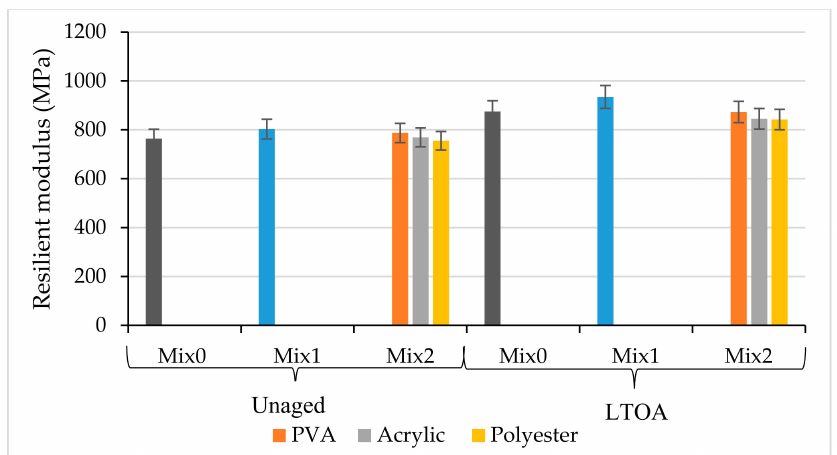
Figure 6. Resilient modulus of the asphalt mixtures at the temperature of 40 ◦